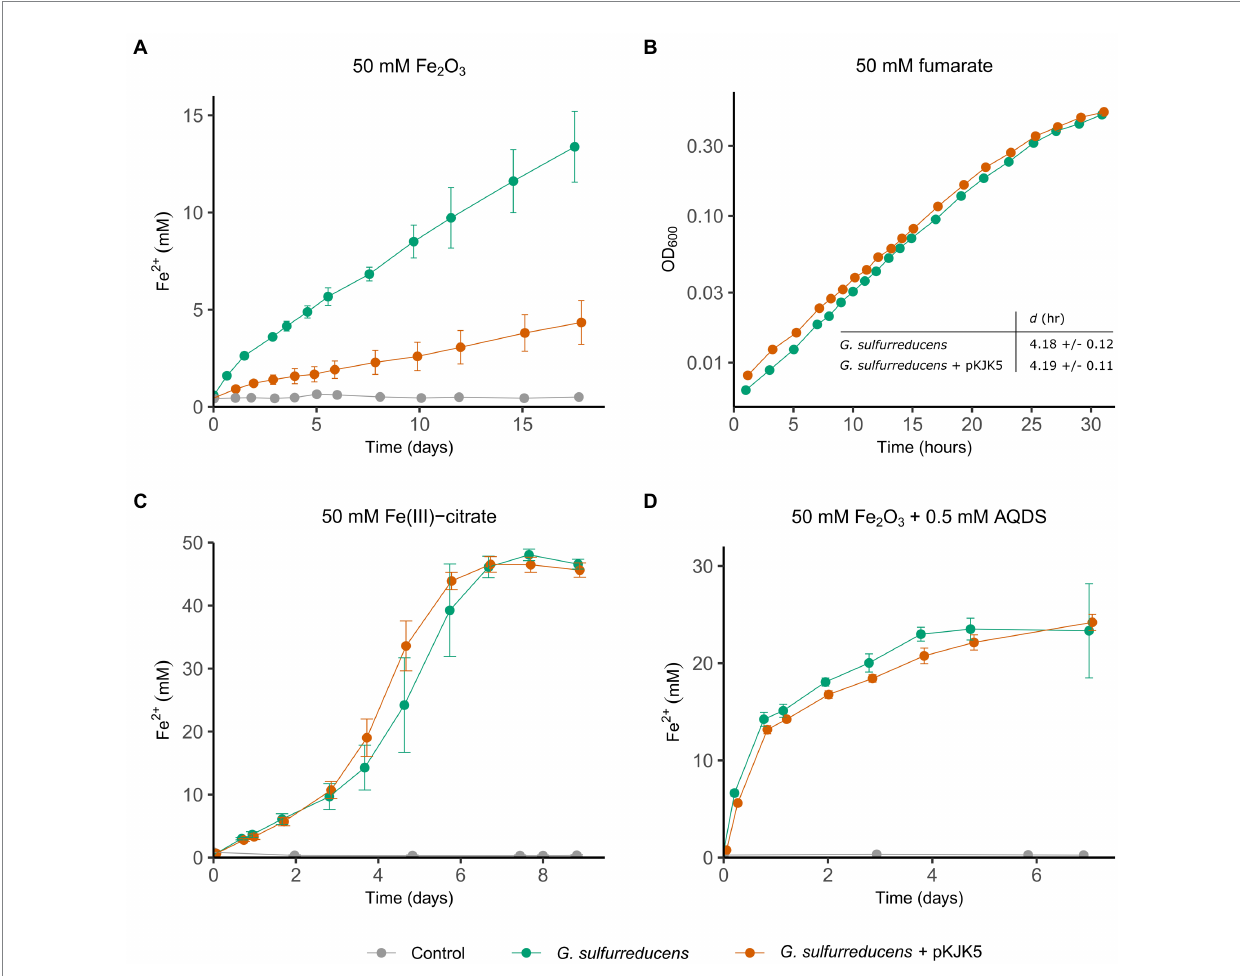
FIGURE 1 pKJK5 inhibits G. sulfurreducens ’ ability to reduce Fe 2 O 3 . G. sulfurreducens with and without pKJK5 was grown in medium with Fe 2 O 3 [ (A) , n = 6], fumarate [ (B) , n = 5], Fe(III)-citrate [ (C) , n = 6] or Fe 2 O 3 + AQDS [ (D) , n = 6] as the only electron acceptor. Growth was either determined by measuring Fe 2+ concentration (A,C,D) or OD 600 ( B ). For growth on fumarate one representative of five replicates is shown along with doubling times with the standard deviation (SD). All the controls are uninoculated medium. Error bars show